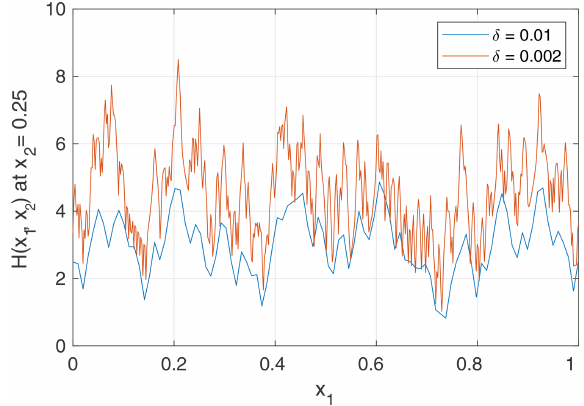
Figure 2. Profiles through the topographies shown in Fig.